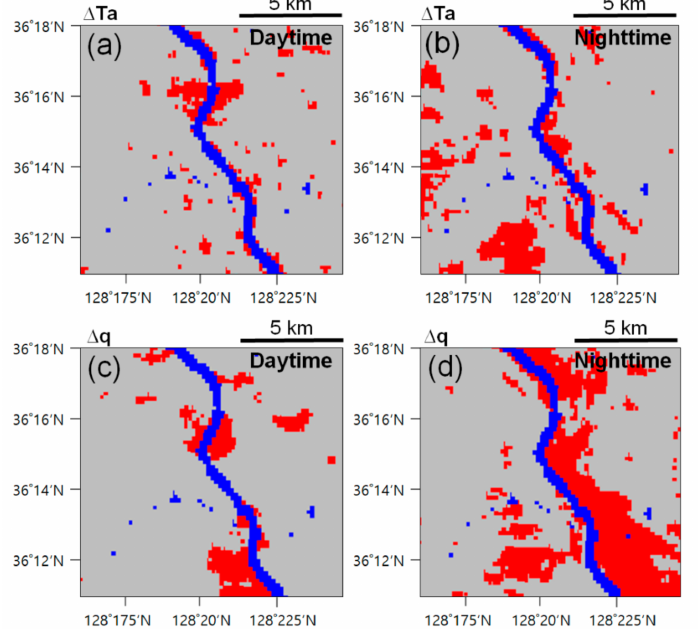
Figure 8. Horizontal distribution of a paired t -test result for ∆ Ta ( a , b ) and ∆ q ( c , d ) in daytime ( a , c ) and nighttime ( b , d ) for Case1. Area with significant change ( p < 0.05) is marked in red, and the water area after weir construction is marked in blue.